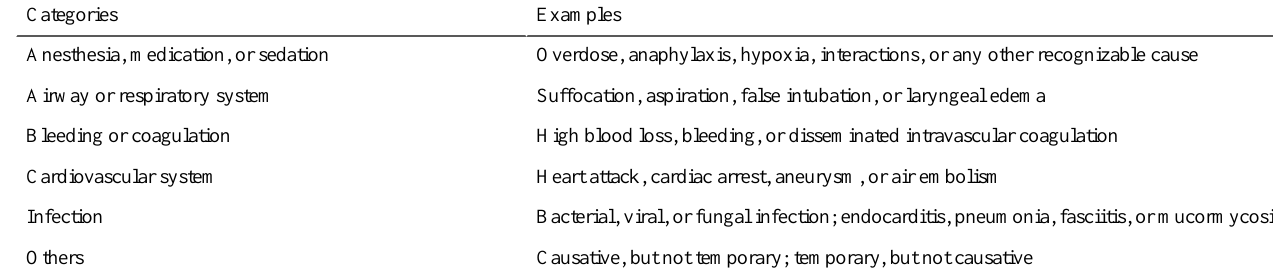
Table 1. Categories of causes of death.